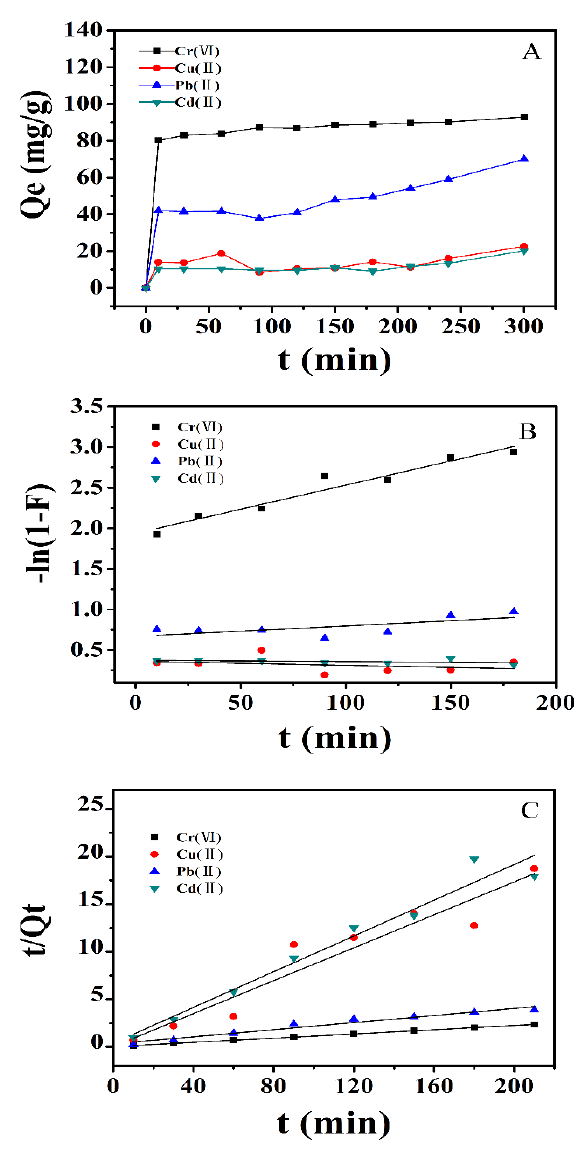
Figure 4: (A) Effects of contact time on the removal of Cr(VI), Cu(II), Pb(II) and Cd(II) by GO-NH ; (B) The simulated pseudo-first-order 2 kinetics and (C) the simulated pseudo-second-order kinetics for Cr(VI), Cu(II), Pb(II) and Cd(II) sorption onto GO-NH . [conditions: 2 C =100 mg L −1 (Cr(VI), Cu(II), Pb(II) and Cd(II)); pH=2.0 Cr(VI), 4.0 0 Cu(II), 5.0 Pb(II), 5.0 Cd(II); adsorbent dose=20 mg;